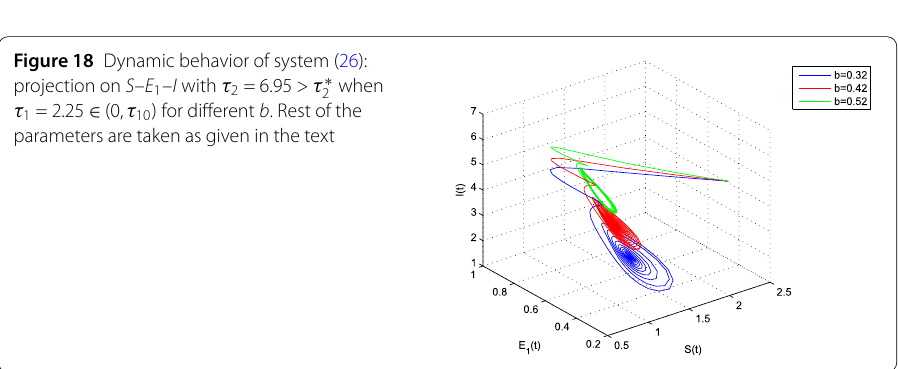
Figure 17 Time plots of S , E 1 , E 2 and I for different b at τ 2 = 6.25 when τ 1 = 2.25 ∈ (0, τ 10 ). Rest of the parameters are taken as given in the text